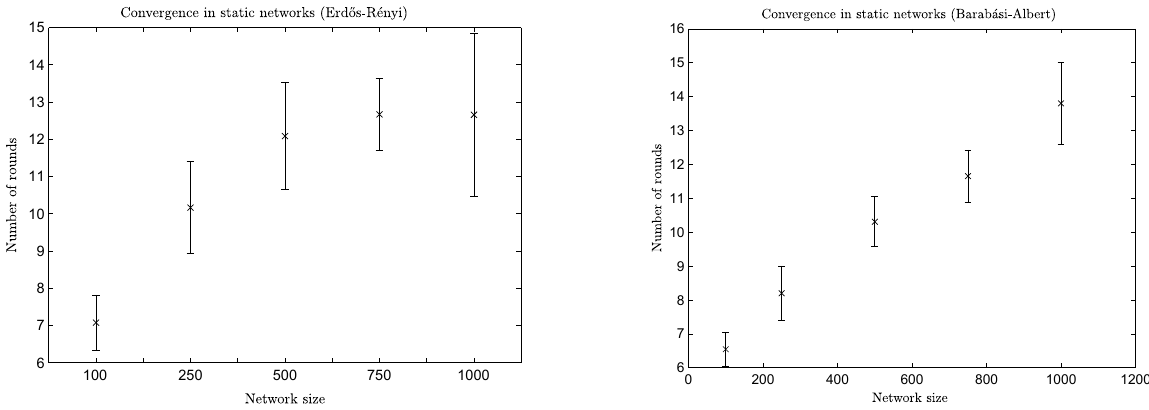
Figure 3. Convergence speed per network